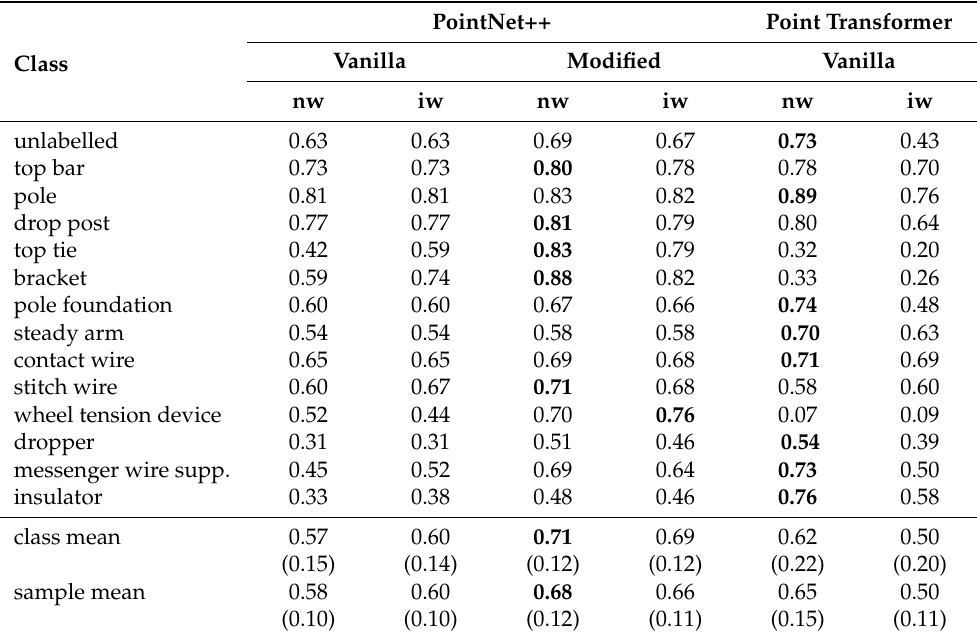
Table 2. Per-class mIoU compared for the vanilla PointNet++ model, the modified PointNet++ model, and the Point Transformer model (standard deviations between parentheses). The term nw refers to non-weighted losses and iw refers to inversely weighted